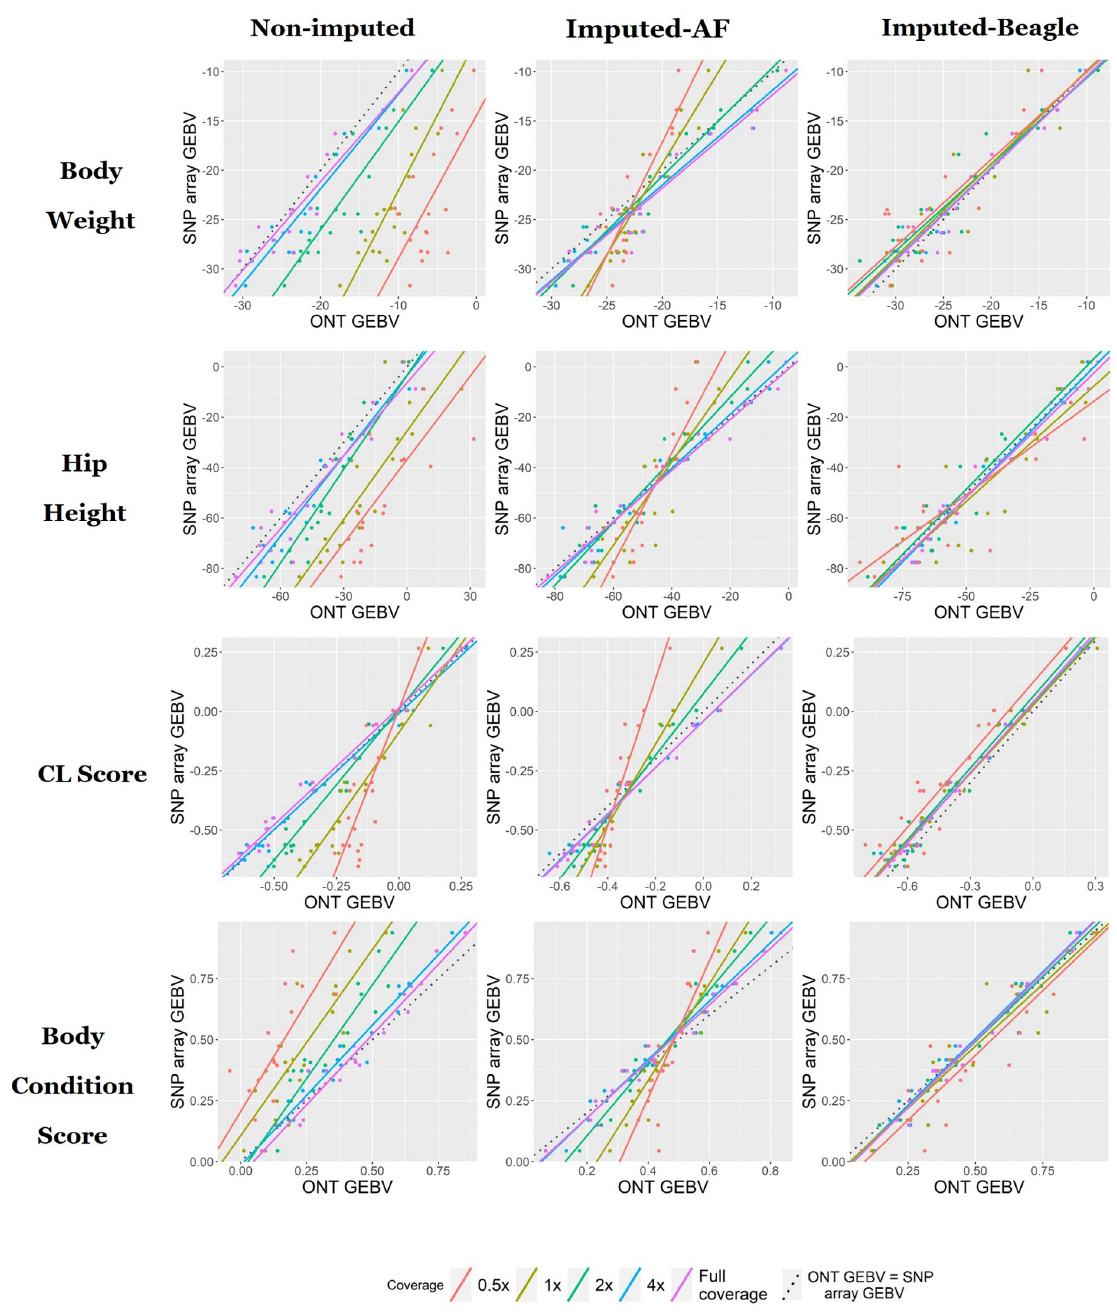
Fig 4. Regression of SNP array genomic predictions on ONT genomic predictions to illustrate the predictions bias for each of the four traits and three genotyping methods used.